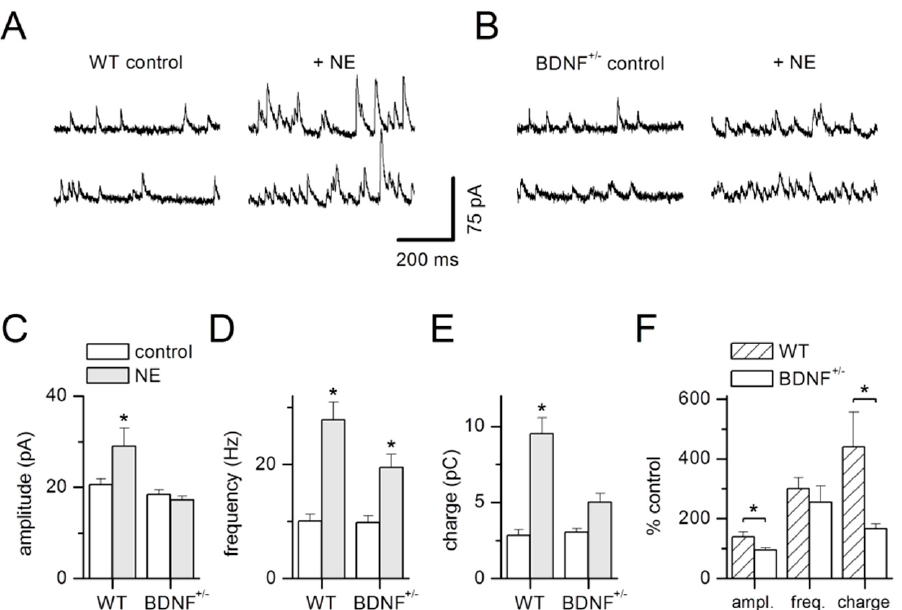
Figure 6. Norepinephrine (NE)-dependent stimulation of GABA-mediated synaptic activity in WT and BDNF +/ − mice. Spontaneous IPSCs (sIPSCs) recorded from the same representative WT ( A ) and BDNF +/ − ( B ) projection neuron, respectively, before and after application of NE (10 µM). ( C ) sIPSC amplitude, ( D ) frequency, and ( E ) charge pooled during control conditions and after addition of NE demonstrates a significant increase in sIPSC amplitude in WT mice only, while frequency of sIPSCs is augmented significantly in both genotypes. ( F ) Increase in sIPSC amplitude and charge was sig- nificantly different in WT versus BDNF +/ − mice, while sIPSC frequency increase was similar in both genotypes. WT: n = 12 neurons from 7 animals, BDNF +/ − : n = 13 neurons from 6 animals. * p < 0.05, Tukey post-hoc comparisons.